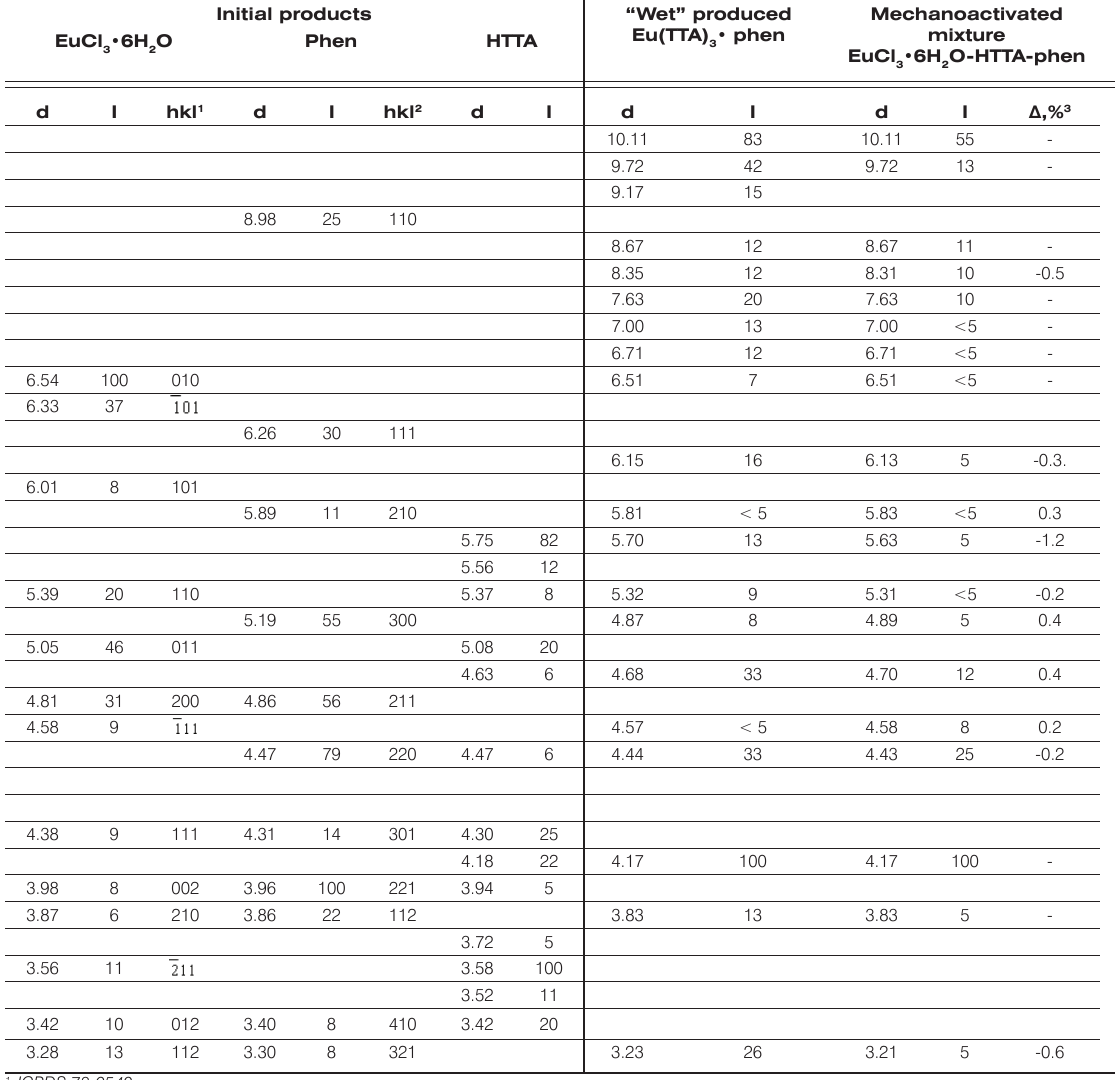
Table 2. Interplanar distances (d, n.10 10 m) and relative intensity (I,%) of the initial EuCl and mechanoactivated